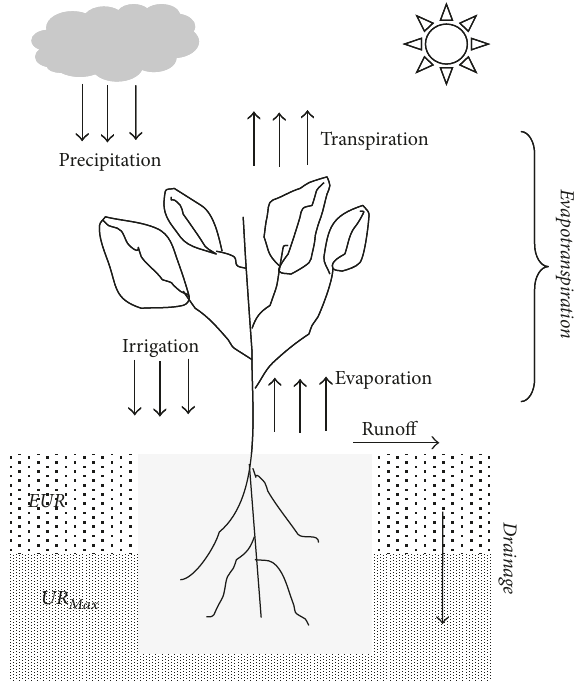
Figure 2: Water balance model.